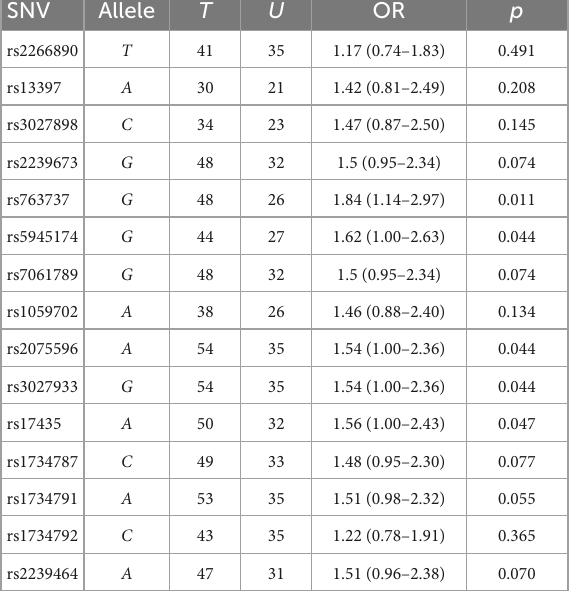
TABLE 2 Transmission disequilibrium test (TDT) of the interleukin-1 receptor associated kinase 1 ( IRAK1) /methyl CpG binding protein